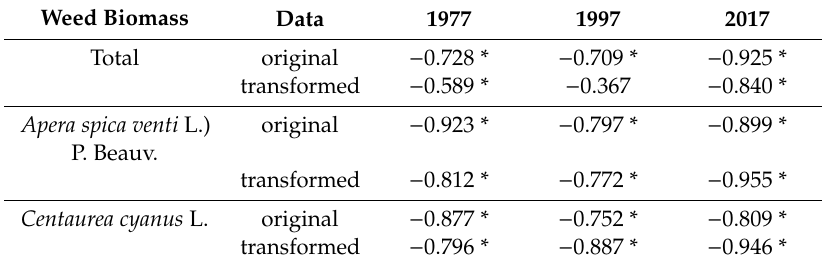
Table 11. Relationship winter rye yield and weed biomass (original or transformed data respectively) shown as simple correlation coe ffi cients. Weed Biomass Data 1977 1997 2017 Total original − 0.728 * − 0.709 * − 0.925 * transformed − 0.589 * − 0.367 Apera spica venti L.) original − 0.923 * − 0.797 * − 0.899 * P. Beauv. transformed − 0.812 * − 0.772 * − 0.955 * Centaurea cyanus L. original − 0.877 *